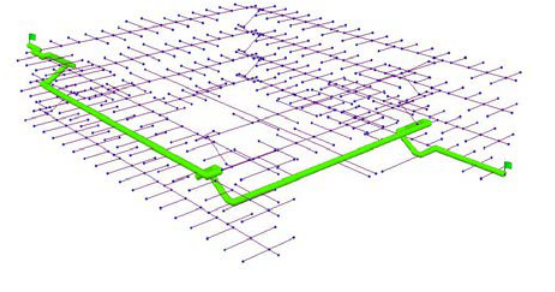
Figure 3. Network analysis testing in 3D